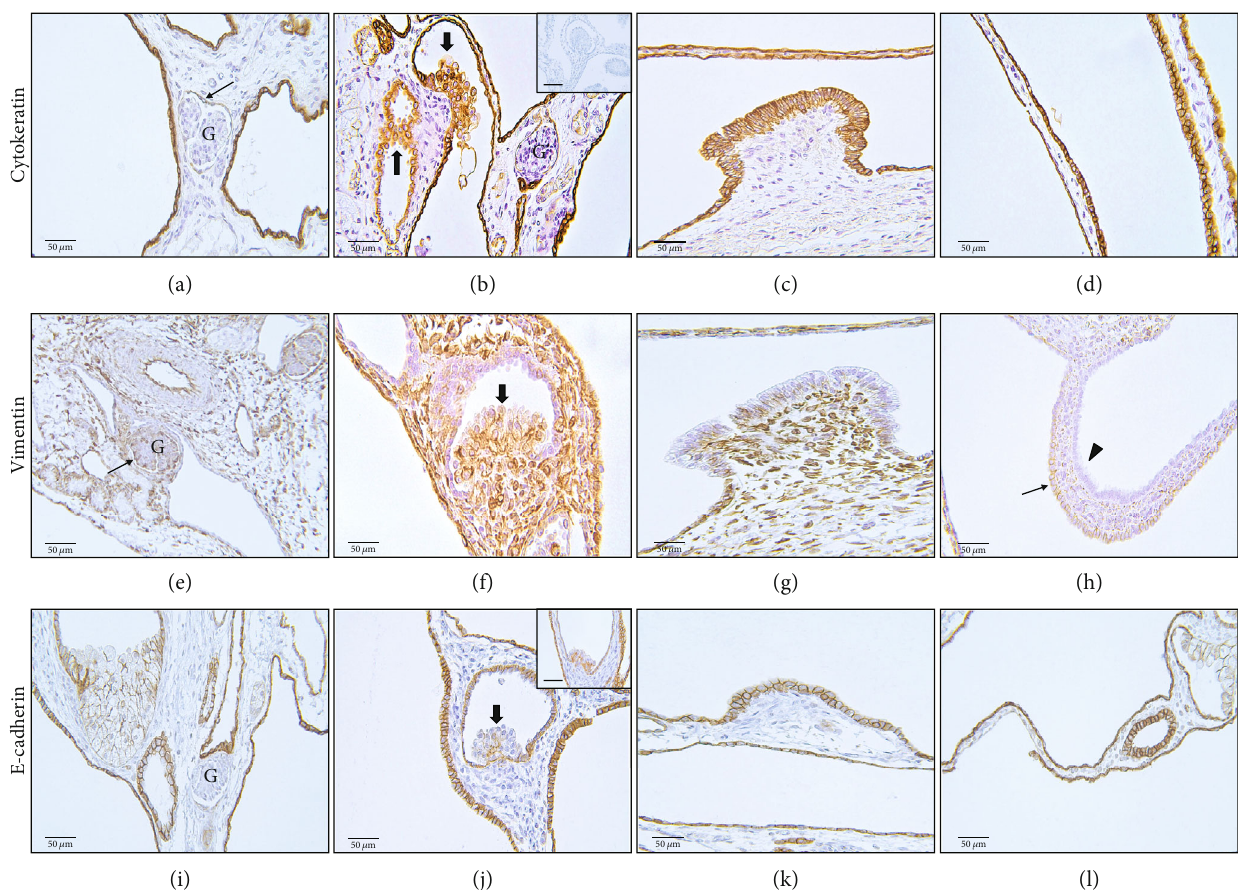
Figure 2: Expression of vimentin, cytokeratin, and E-cadherin (immunohistochemistry). Cytokeratin (a – d): (a) no visible cytokeratin expression within glomerular structures (G), single pericytes weakly express cytokeratin (arrow). (b) Homogenous expression pattern within the polypoid proliferates/projections, which additionally lack expression of cytokeratin 7 (inset). (c, d) Protrusions and the epithelial lining of the cysts feature a homogenous expression pattern. Vimentin (e – h): (e) vimentin gets expressed in the podocytes (arrow) of the glomeruli (G). (f) Furthermore, it is homogenously expressed in the polypoid proliferates and indicates a divergent expression pattern in protrusions (g) and cyst wall linings (h), showing positive (arrow) and negative sections (arrowhead). E-cadherin (i – l): (i) there is no E-cadherin expression within glomerular structures (G). (j) The epithelial proliferates/projections occur with a complete or apical (inset) loss of E-cadherin, sometimes associated with a basal displacement of E-cadherin expression. Cell morphology is characterized by a marked foamy cytoplasmic texture. E-cadherin mainly is expressed in intra- and intercellular areas of the protrusions (k) and the cyst wall lining